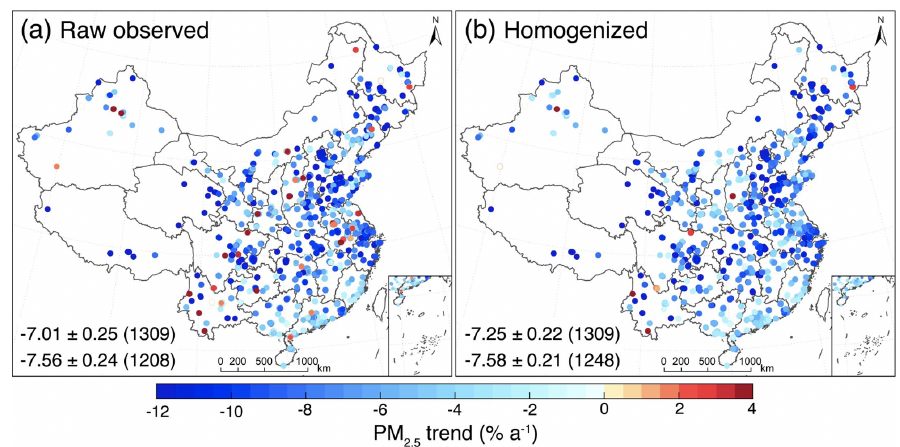
Figure 10. Linear trends for (a) raw observed and (b) homogenized daily PM 2 . 5 concentration data during 2015–2019 in the study area. Solid circles indicate trends are statistically significant at the 95% confidence interval. Numbers shown in the lower left of each panel indicate the overall trend derived from (top) all available stations and (bottom) the stations with significant trends at the 95% confidence interval while the numbers shown in brackets are the corresponding number of data records. Each PM 2 . 5 time series was standardized by its mean annual cycle during the study period to account for spatial variations of PM 2 . 5